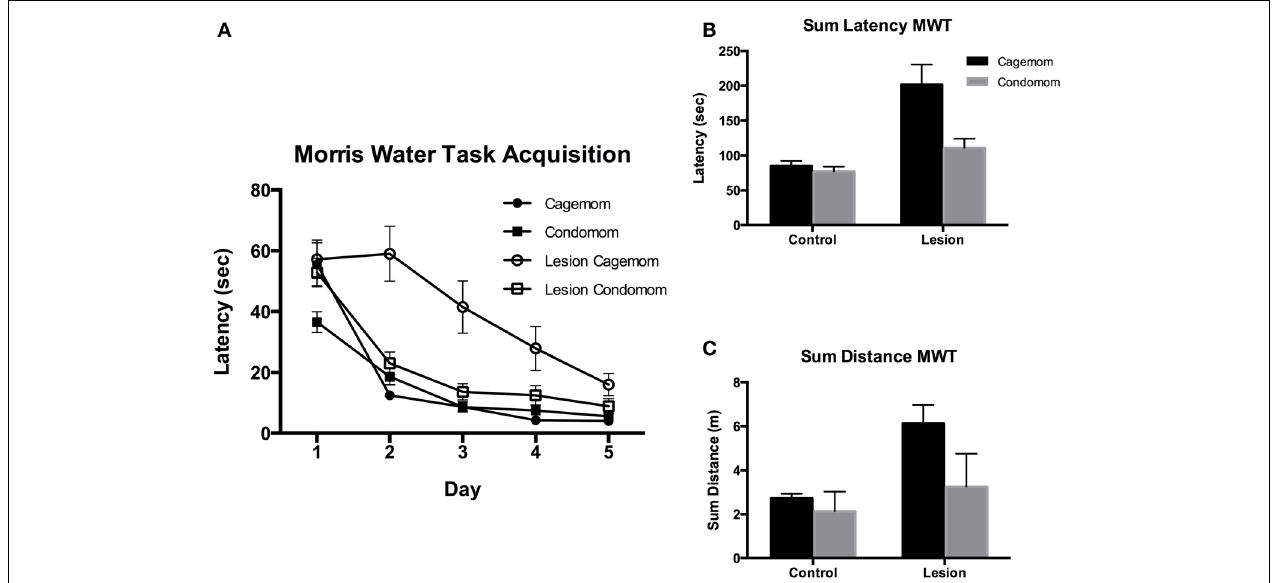
FIGURE 2 | (A) Acquisition of learning the location of a hidden platform in the Morris Water. Task over 5 days of testing. Condomom animals with early lesions acquired the task faster than did cagemom animals with similar injury and did not differ from the performance of the cagemom controls. Latency is reported in seconds. (D, Days; C, Control; L, P3 Lesion). (B) Latency in seconds to find a hidden platform averaged and summed over 5 days of testing. Control animals found the platform faster than did animals with early